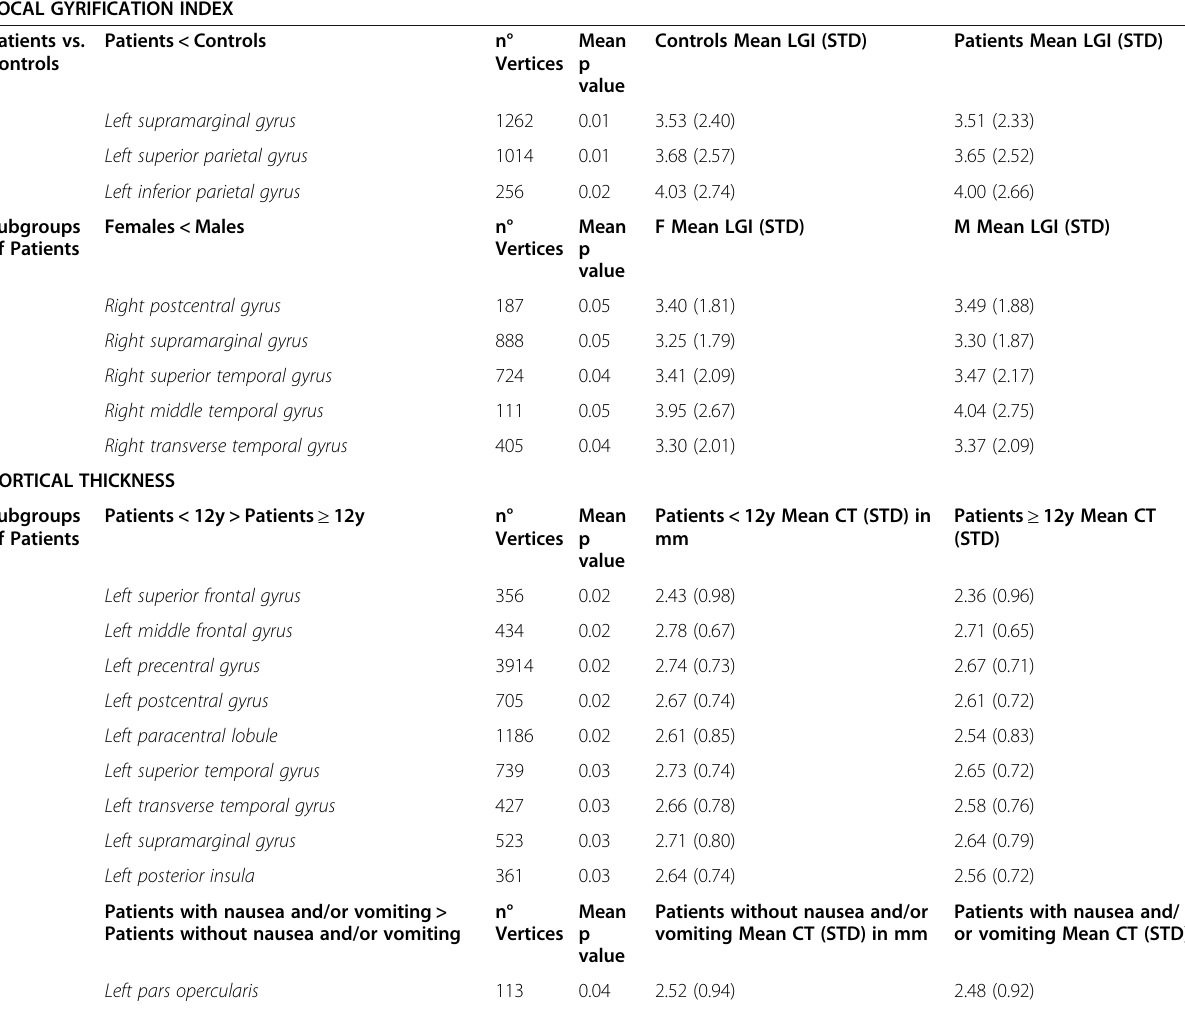
The table illustrates the results from statistical analysis performed separately on cortical thickness and gyrification between: healthy patients and patients; subgroups of healthy controls and subgroups of patients. LGI: local gyrification index; CT: cortical thickness; mm: